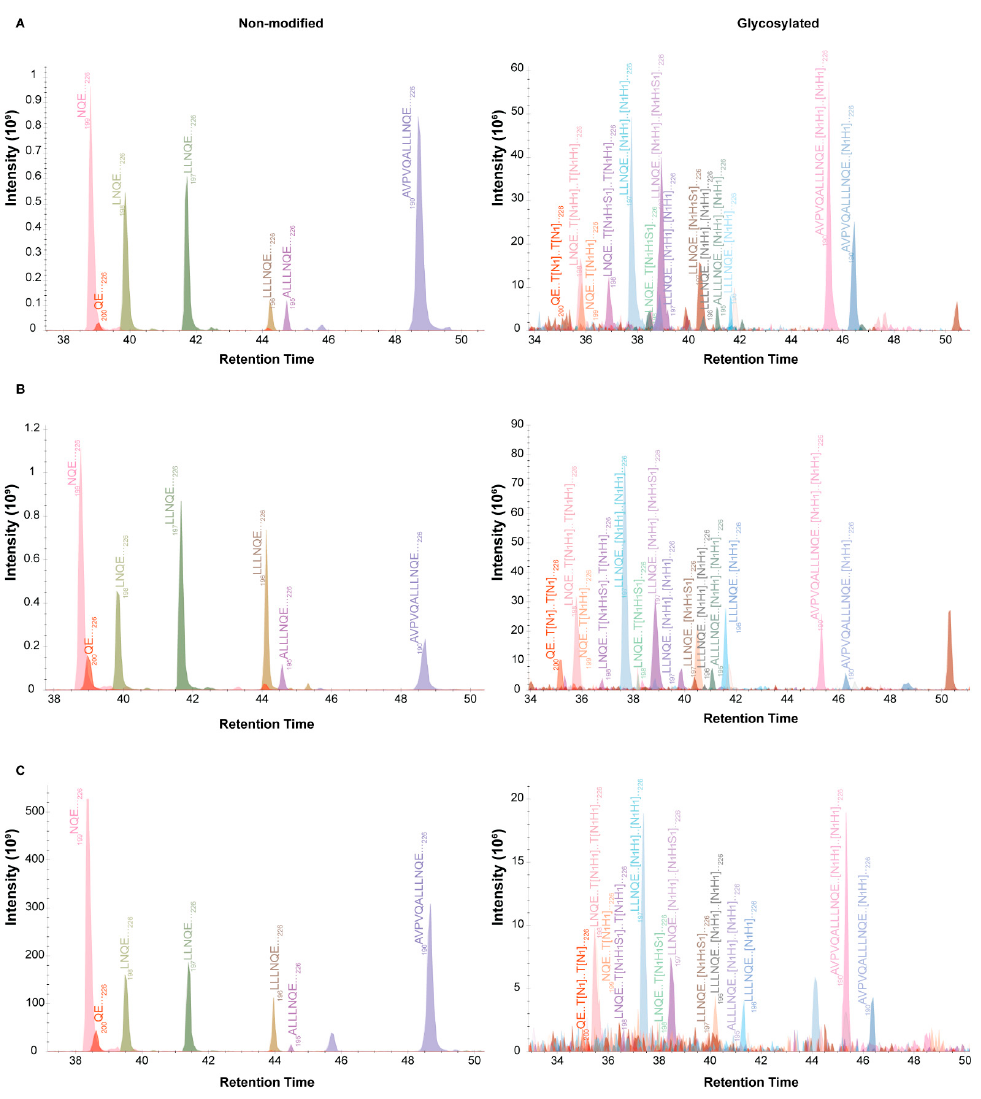
Figure 7. Changes in abundances of O -glycosylated peptide variants during early and late lactation. All presented ion traces originate from donor one and show the C-terminal β -casein ladder peptide series beginning with 190 AVPVQALLLNQ ELLLNPTHQIYPVTQPLAPVHNPISV 226 and ending with the antimicrobial peptide 200 QELLLNPTHQYPVTQPLAPVHNPISV 226 . All ladder peptides are decorated by different O -glycan species, as containing a single glycan on Thr207 or Thr214, or having both sites occupied. All ladder peptides were found decorated with N 1 , N 1 H 1 or N 1 H 1 S 1 glycan species. Precursor ion traces are depicted as non-modified (left) and glycosylated (right). ( A ) MS1 traces of the differing glycopeptides relative to the non-modified peptide in week 1. ( B ) MS1 traces of the differing glycopeptides relative to the non-modified peptide in week 6. ( C ) MS1 traces of the differing glycopeptides relative to the non-modified peptide in week